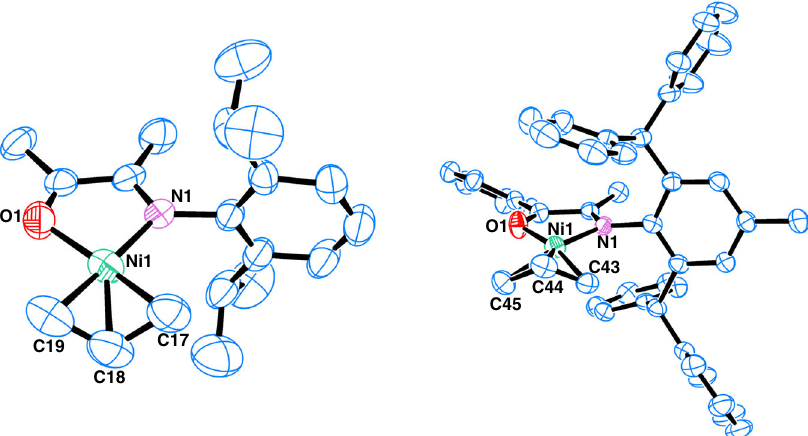
Fig. 3 Molecular structures of Ni1 and Ni6. Hydrogen atoms and BAF group were omitted for clarity. Selected bond lengths (Å) and angles (°): Ni1 – N1 = 1.925(3), Ni1 – O1 = 1.946(3), Ni1 – C17 = 1.98(8), Ni1 – C18 = 1.916(18), Ni1 – C19 = 1.95(7), N1 – Ni1 – O1 = 82.05(13), C19 – Ni1 – C17 = 74(3); Ni1 – C44 = 1.921 (14), Ni1 – O1 = 1.923(4), Ni1 – N1 = 1.942(4), Ni1 – C43 = 2.01(5), Ni1 – C45 = 2.03(2), O1 – Ni1 – N1 = 81.29(16), C43 – Ni1 – C45 = 72.3(17).